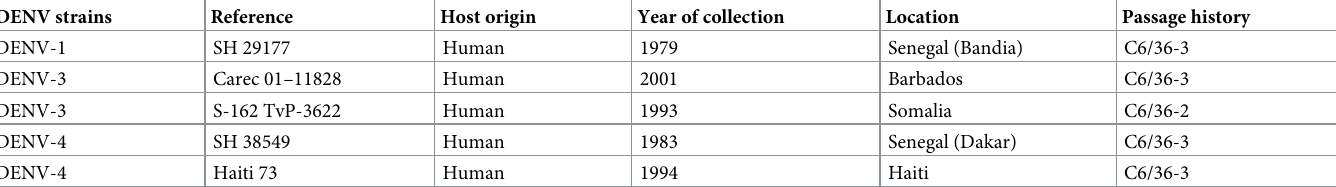
Table 2. Dengue virus strains used for this study. DENV